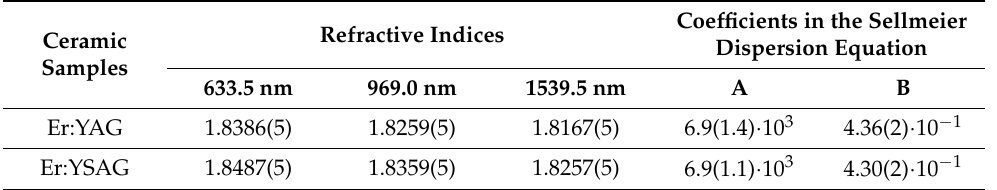
where (–A), the slope of the plot of (n 2 − 1) − 1 versus λ − 2 , gives a measure of dispersion and B, the intercept of the plot at λ = ∞ , gives n ∞ = (1 + 1/B) 1/2 . Table 2. Measured refractive indices of the ceramic samples and coefficients in the Sellmeier disper- sion equation.